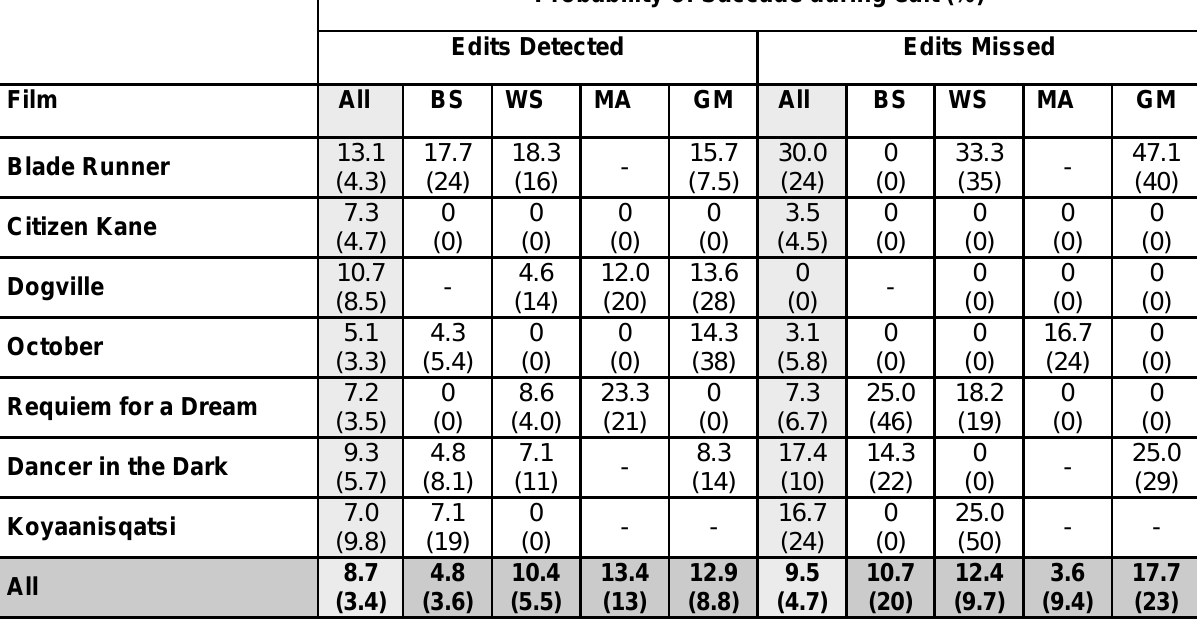
Table 3 : Probability (%) of there being a saccade during an edit which was detected or missed. Results are split by film (rows), presented for all edits (vertical light grey, ‘All’ columns), for valid cuts with shot size CU, CMS, or MS and type Between Scene (BS), Within Scene (WS), Match Action (MA), and Gaze Match (GM). Means across all films are presented on the bottom row . Standard Deviations are presented in